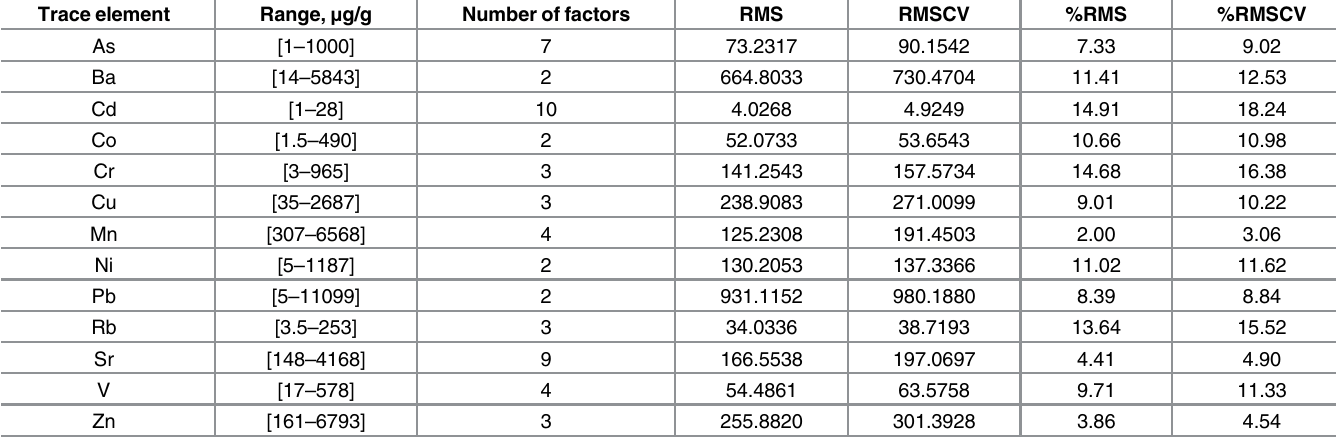
Table 2. RMS and RMSCV errors of the constructed PLS